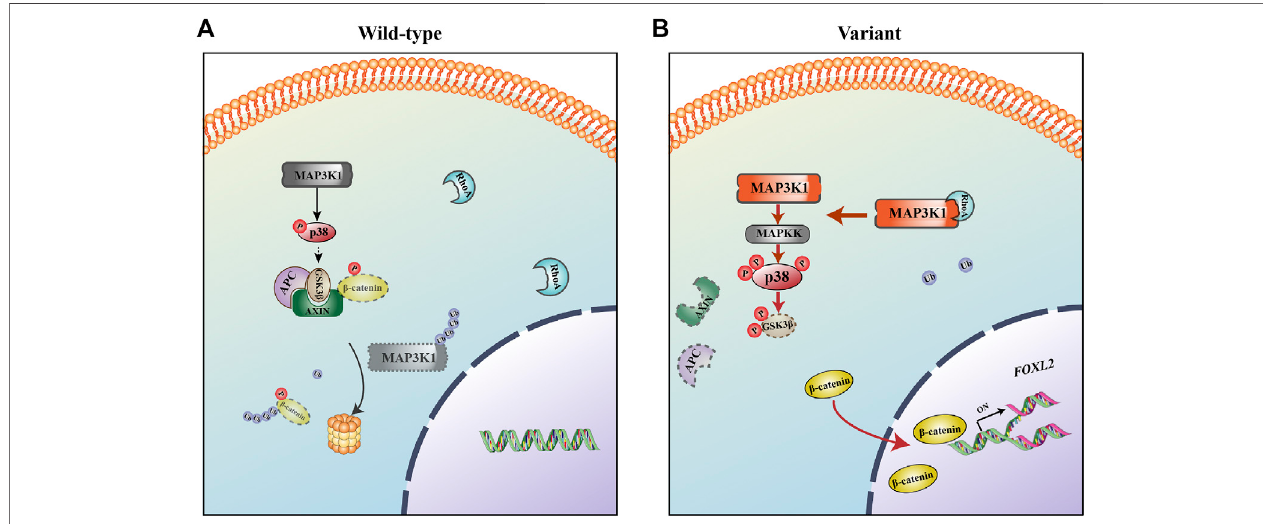
FIGURE8| Themechanismfor46,XYDSDascausedbytheMAP3K1 R186G variant. (A) Inthewild-type,MAP3K1tendstobedegradedbyauto-ubiquitination. (B) In the mutant, MAP3K1 R186G enhances its binding to RhoA and stability, causing hyperphosphorylation of p38 and GSK3 β , activating the Wnt4/ β -catenin/FOXL2 pathway, and in turn resulting in 46, XY